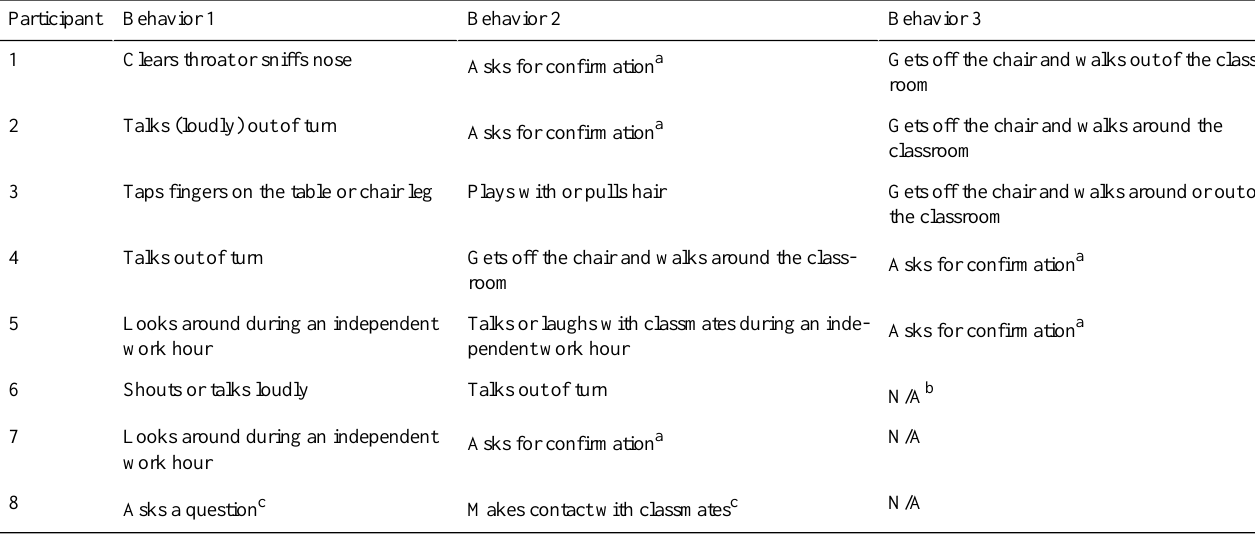
Table 2. Disruptive classroom behaviors of each participant, indicated by their